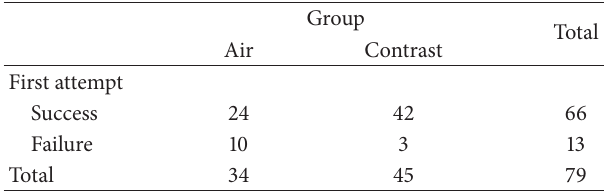
Table 3: Comparison of the success rate on the first